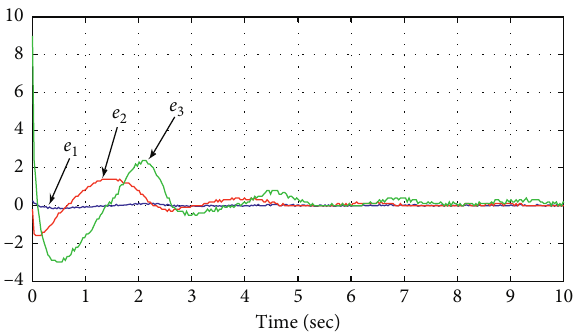
Figure 9: Time evolution of the estimation error e for the implemented